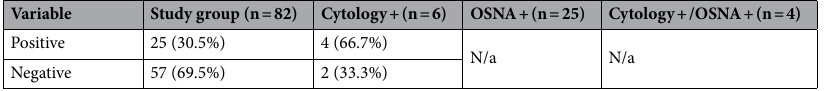
Table 1. Patients characteristics. N/a not applicable, (y)pT (post neoadjuvant) pathological primary tumour stage, (y)pN (post neoadjuvant) pathological nodal stage, (y)pM (post neoadjuvant) pathological distant